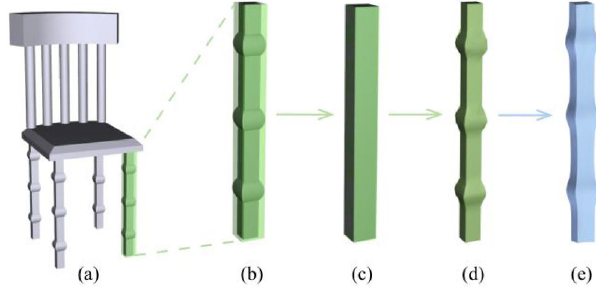
Fig. 5 Representing a chair leg by deforming the bounding box using SDM-NET . Reproduced with permission from Ref. [27], c (cid:2) ACM 2019.